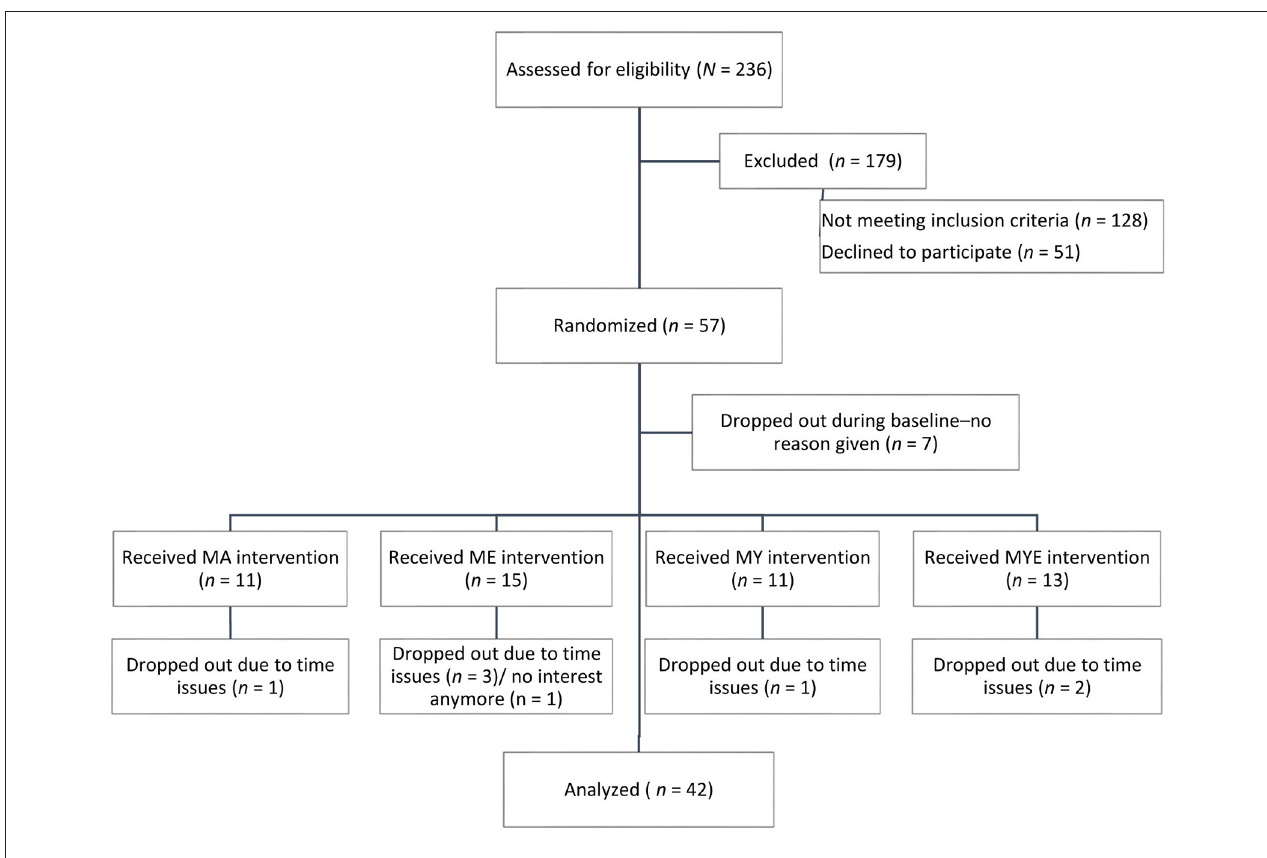
FIGURE 2 | CONSORT flow chart of participants in the study.